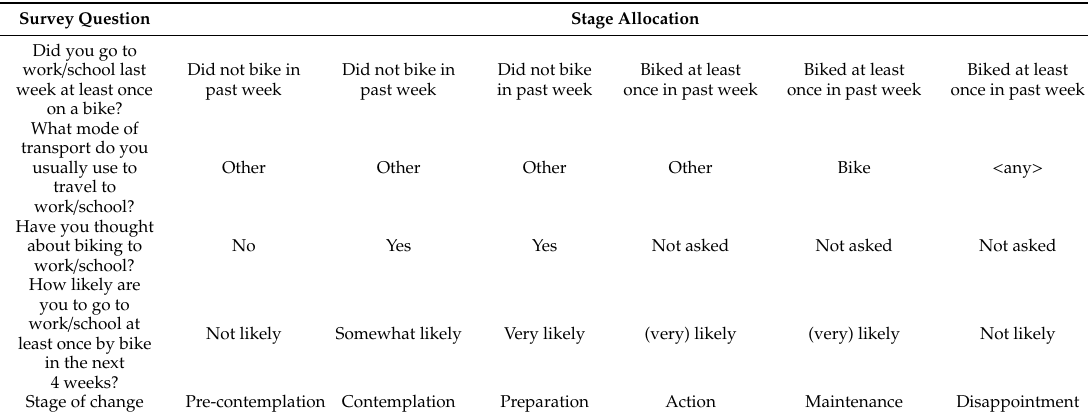
Table 1. Stages-of-change